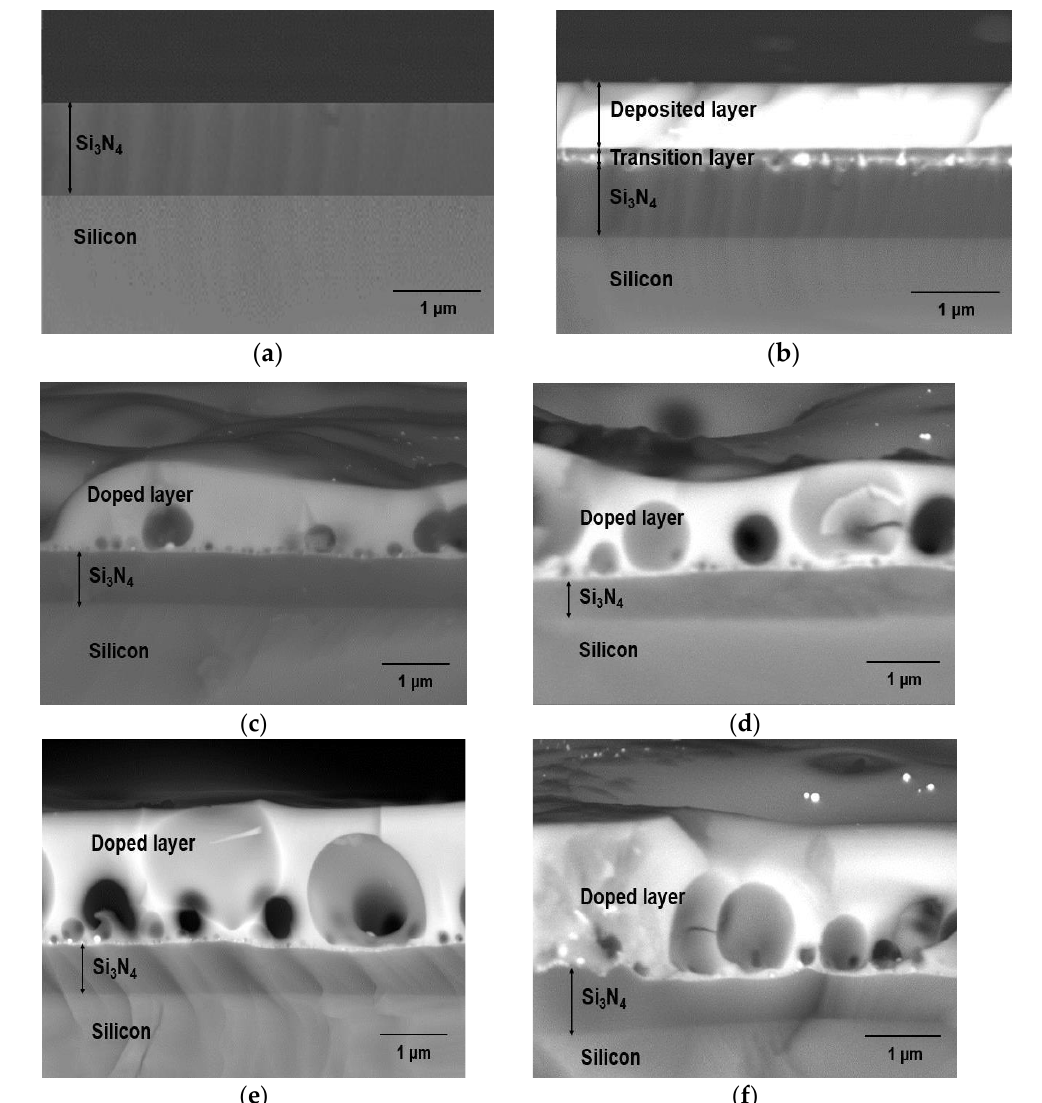
Figure 8. BSE cross-sectional SEM images of ( a ) bare Si 3 N 4 -on-silicon substrate, and samples doped with Er-TZN into Si 3 N 4 -on-silicon when substrate was heated at ( b ) 470 ◦ C (K470) ( c ) 520 ◦ C (K520), ( d ) 570 ◦ C (K570), ( e ) 600 ◦ C (K600), and ( f ) 650 ◦ C (K650). Table 4. The thickness of the upper layer and Si 3 N 4 underneath, as measured by SEM for samples K470, K520, K570, K600, and K650.